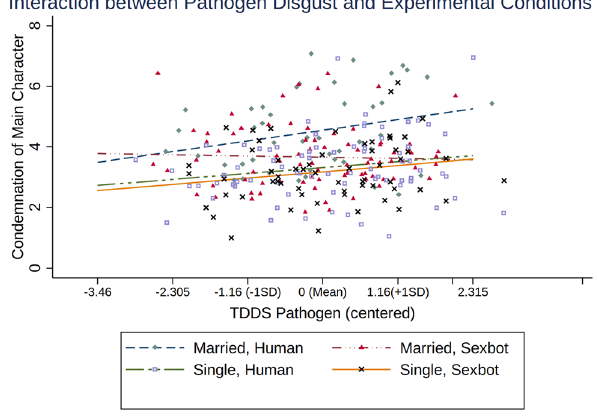
Figure 3: Interaction between pathogen disgust and experimental conditions in the main